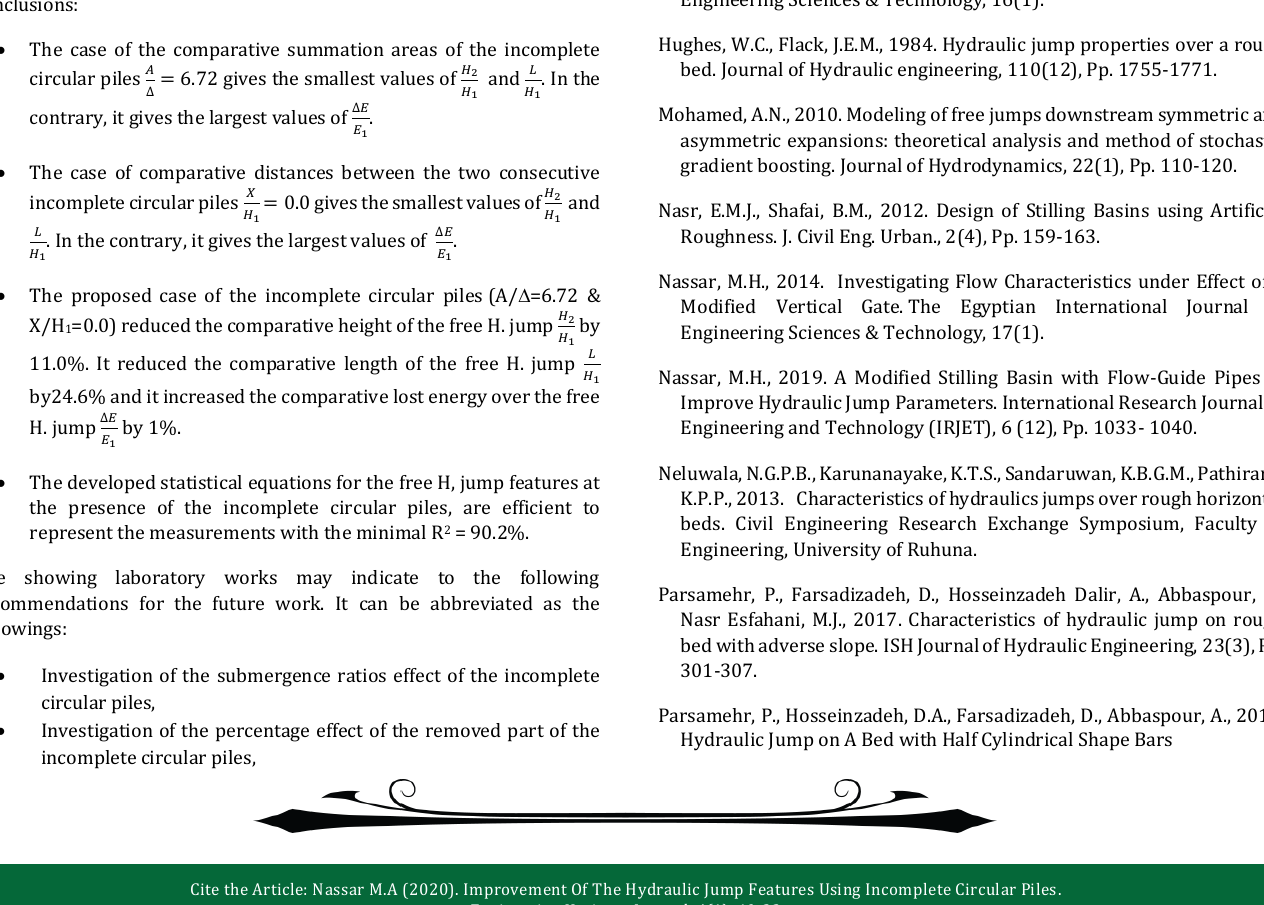
Figure 32: The relationship between the residuals’ values versus the statistical validating comparative height of the free H. jump Eq. (2).